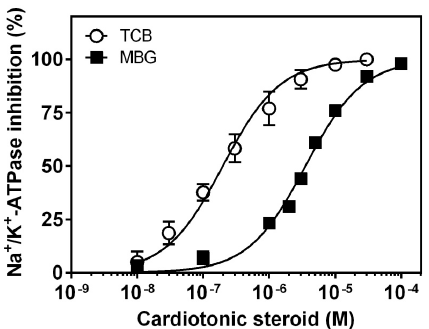
Figure 1. Inhibition curves of pig kidney Na + /K + -ATPase activity by telocinobufagin (TCB) or marinobufagin (MBG). Preparation of Na + /K + -ATPase from pig kidney was incubated with increasing concentrations of TCB or MBG for 1 h. Each point represents the mean ± SEM of three independent experiments performed in triplicate.